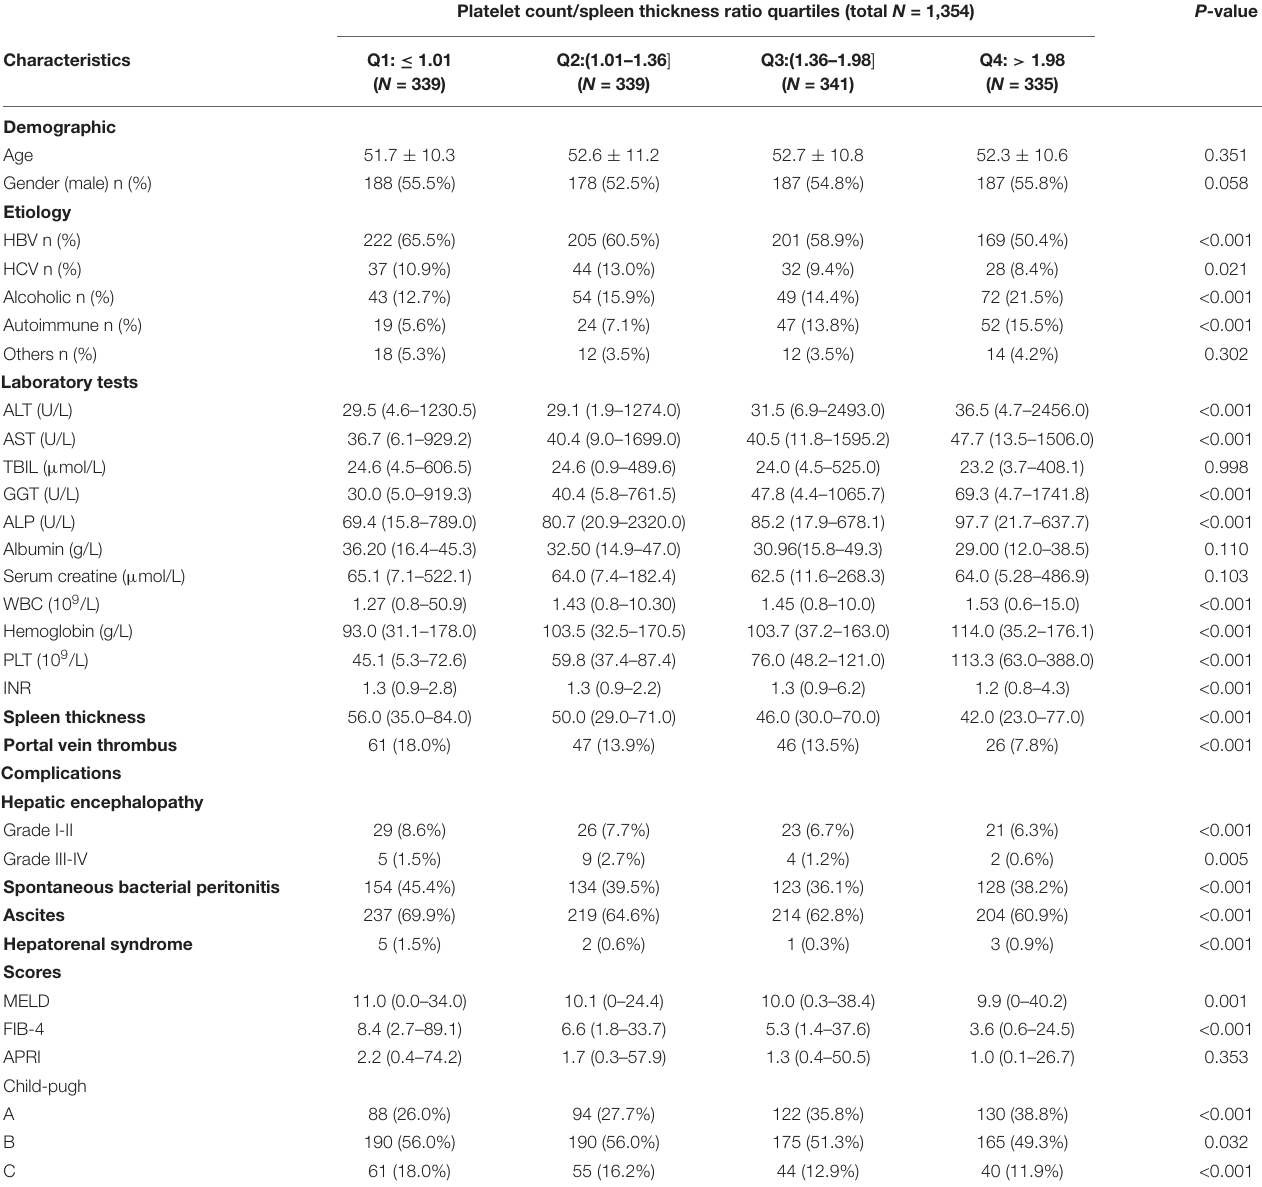
TABLE 1 | Characteristics of patients with esophagogastric varices according to the different platelet count to spleen thickness ratio quartiles. Platelet count/spleen thickness ratio quartiles (total N =